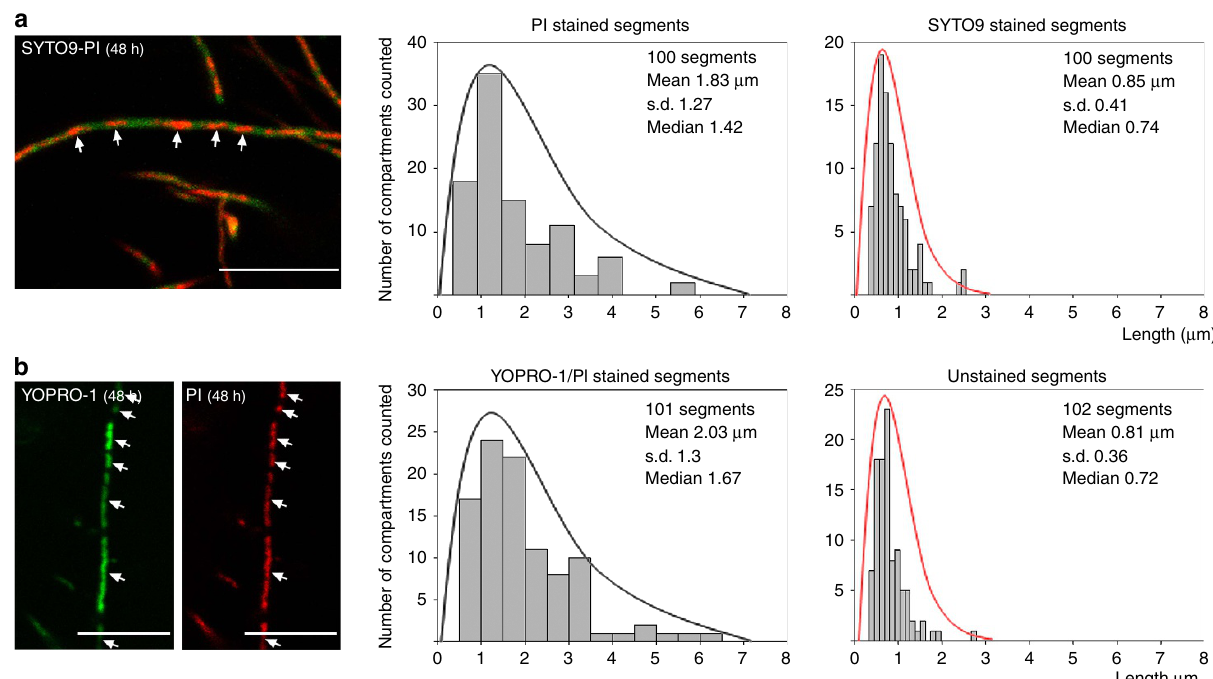
Figure 5 | Confocal laser scanning fluorescence microscopy analysis of the ftsZ mutant HU133. ( a ) SYTO9 (green) and PI (red) staining (48h). ( b ) YOPRO-1 (green) and PI (red) staining (48h). Histograms of the stained and unstained segments are shown. Two distributions were observed: one from viable segments stained with SYTO9 and not stained with YOPRO-1 or PI (red lines); the second from dying cells stained with YOPRO-1 and/or PI (black lines). The scale bars correspond to 8 m m.